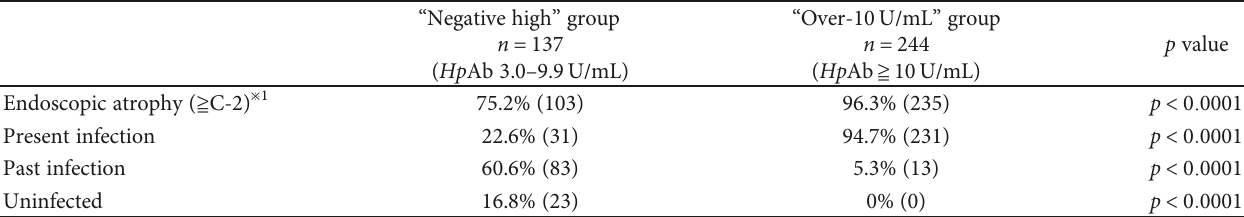
Table 3: The characteristics of the 381 patients evaluated for severity of endoscopic atrophy and Hp infection status.